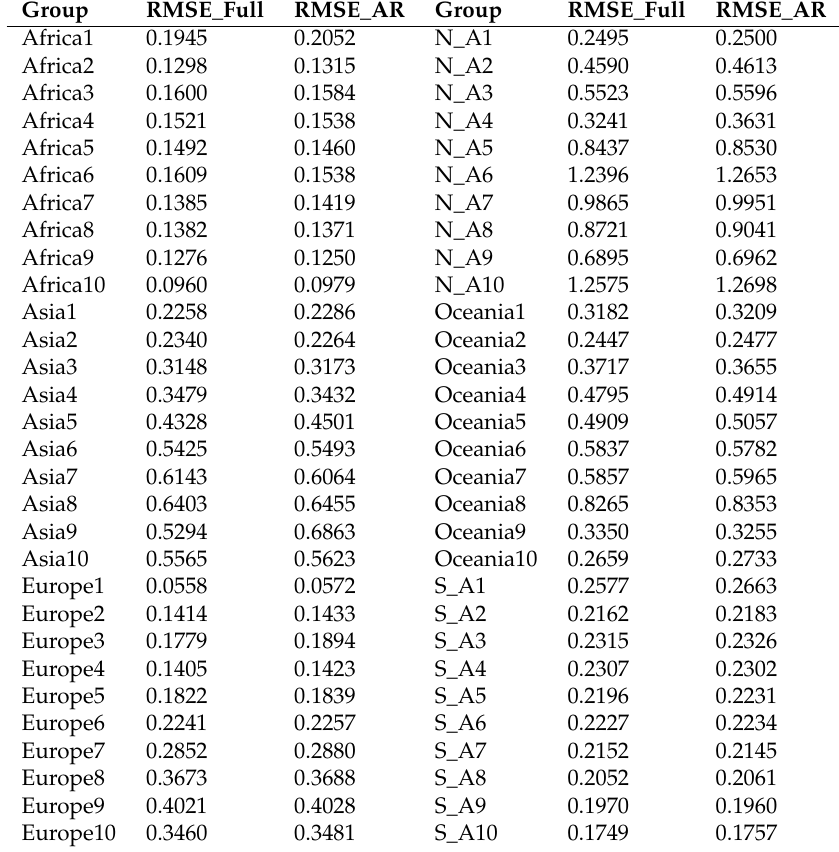
Table 2. Comparison between the root mean square errors obtained with our full VAR model and with a model composed by the solely autoregressive